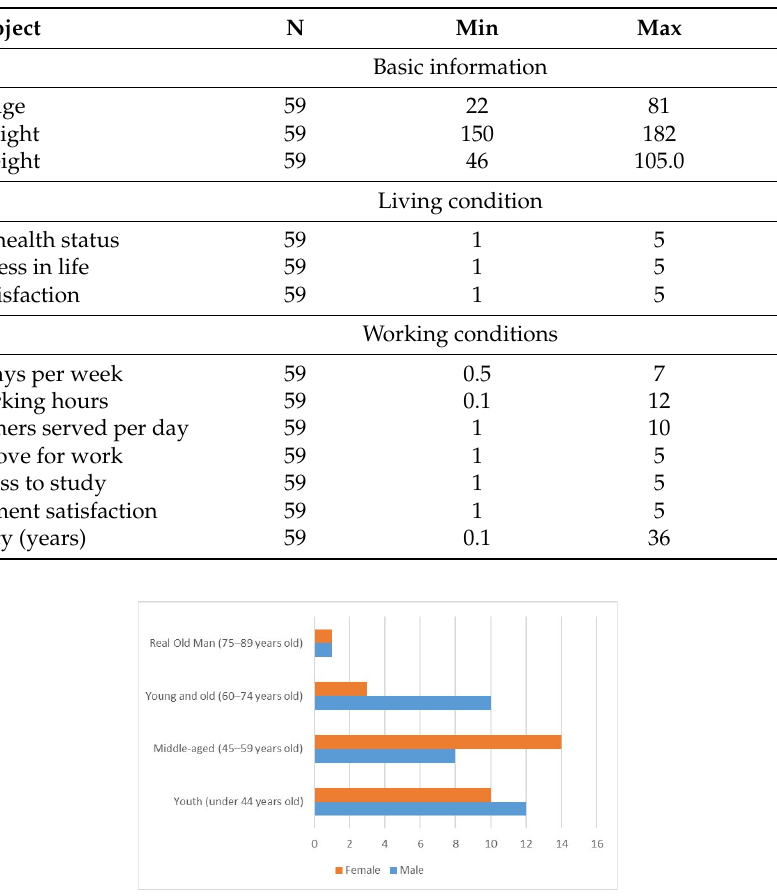
Table 1. Statistical table of basic information of the respondents.